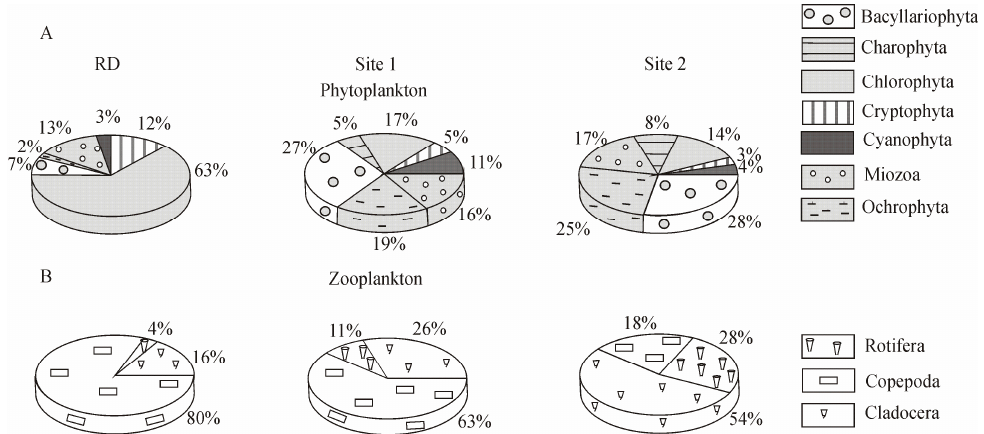
Figure 4. The proportion of higher taxa in the formation of the total plankton biomass in the studied areas of the Baikal coastal zone. ( A ) Percentage ratio of biomass of phytoplankton higher taxa; ( B ) percentage ratio of biomass of zooplankton higher taxa. RD—reference data, including samples collected in the southern basin of Lake Baikal in the past century; Site 1 included stations I, II, and III of the background area in 2016; Site 2 included stations IV, V, and VI of the area with human activity in 2016 (see Figure 1D).